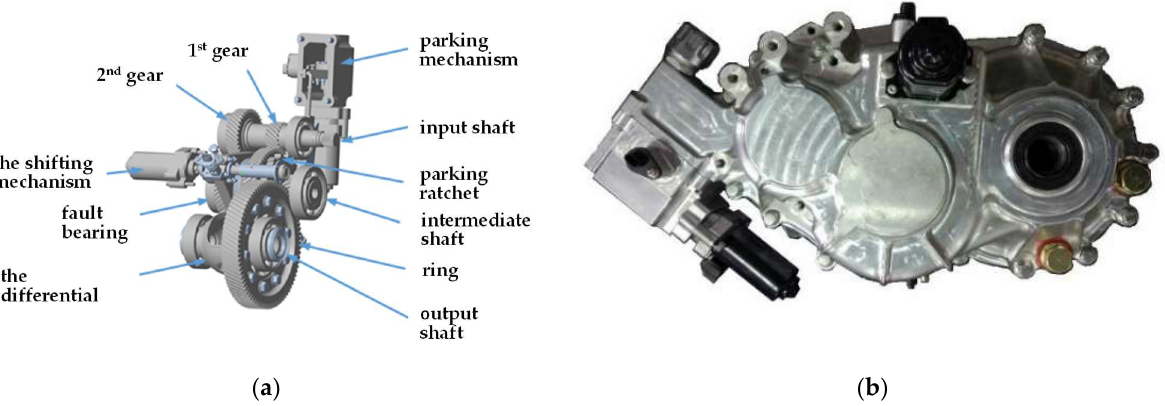
Figure 2. The two-speed automatic mechanical transmission: ( a ) Structural diagram; ( b ) Transmis- sion prototype.